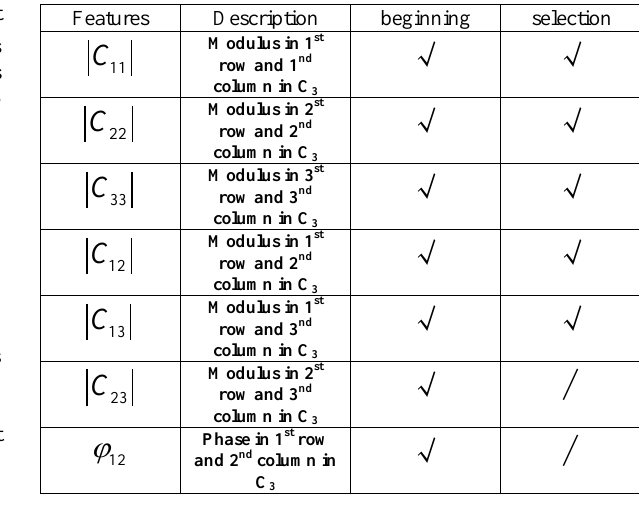
Figure 3. The influences of different combinations of  and C , (a)  =1 and C =10, accuracy is 65.33%. (b)  =0.1 and C =300, accuracy is 87.50%. (c)  =0.5 and C =30, accuracy is 60.02%. (d)  =0.03125 and C =445.7219, accuracy is 93.17%. (e) Select suitable features to classify paddy, accuracy is 97.49%. (f) GA race evolutionary